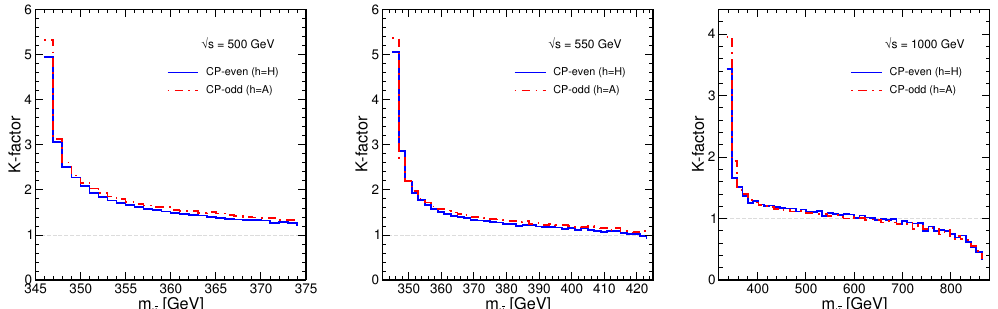
+ e (cid:0) ht (cid:22) t process for the CP-even !